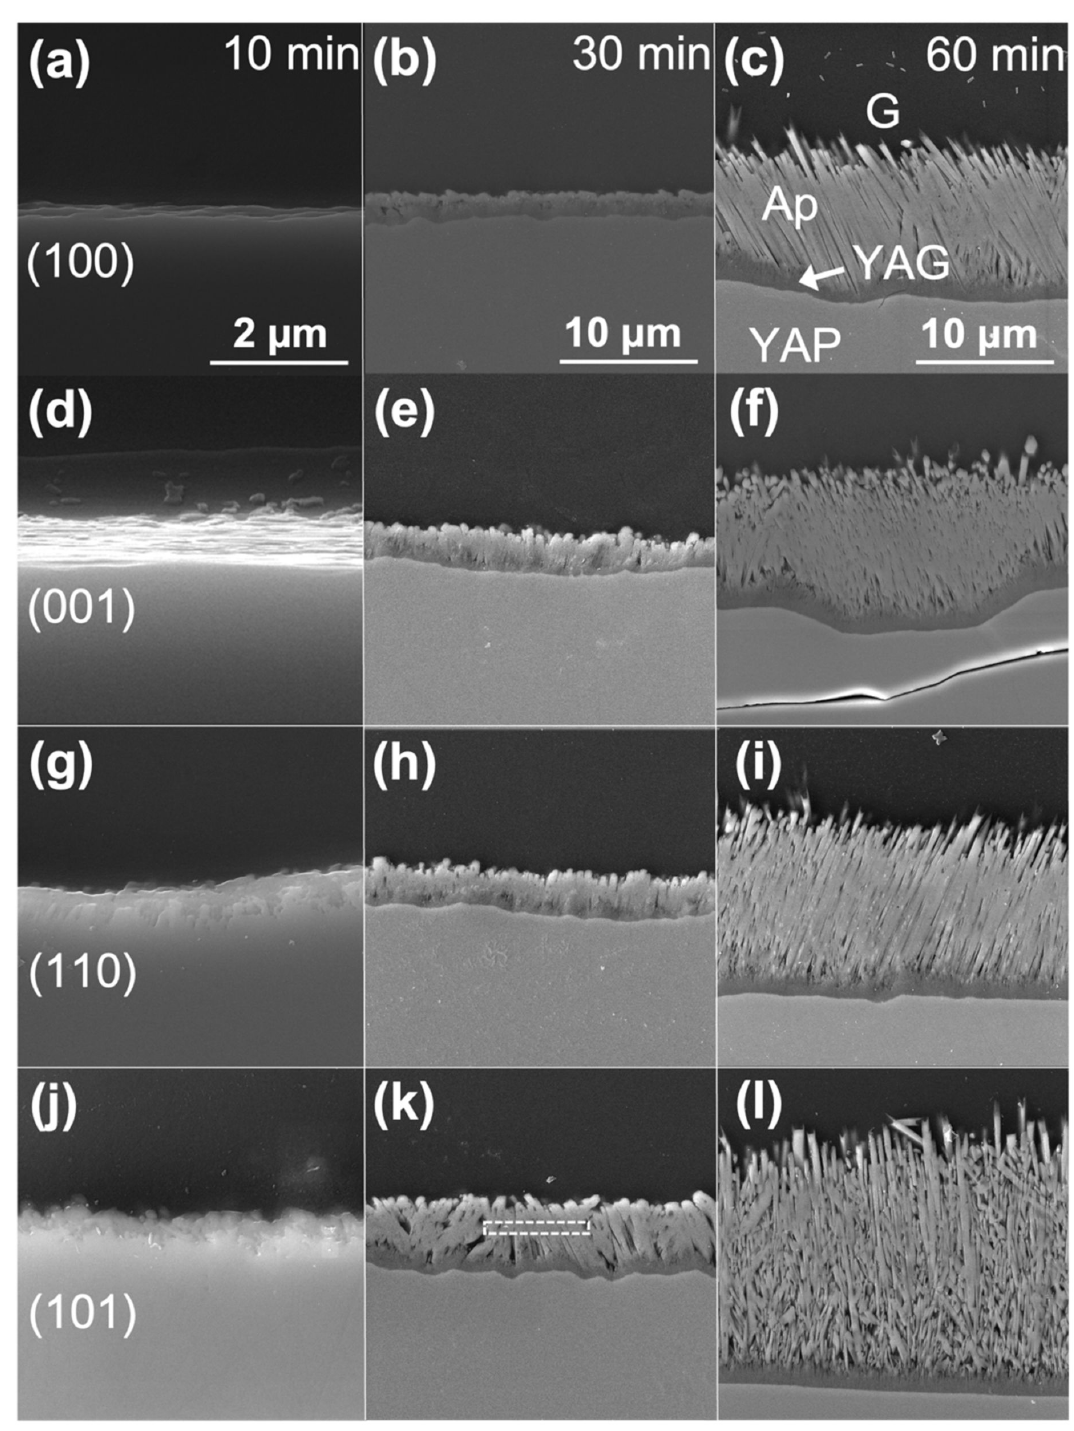
Figure 5. Micrographs that show the CMAS attack progression at the center of the reaction region for all four substrates at 1350 ◦ C. Cross-section SE micrographs collected at the YAP/CMAS interface for ( a – c ) (100), ( d – f ) (001), ( g – i ) (110), and ( j – l ) (101) substrates at ( a , d , g , j ) 10, ( b , e , h , k ) 30 and ( c , f , i , l ) 60 min. The contrast used to identify the CMAS glass (G), apatite (Ap), YAG, and YAP phases are indicated in ( c ). The scale bar is consistent for substrates with the same exposure time. Note that the scale for the 10-min samples is different from the 30- and 60-min samples as indicated. The dashed box in ( k ) indicates a region from where the TEM sample was extracted using the